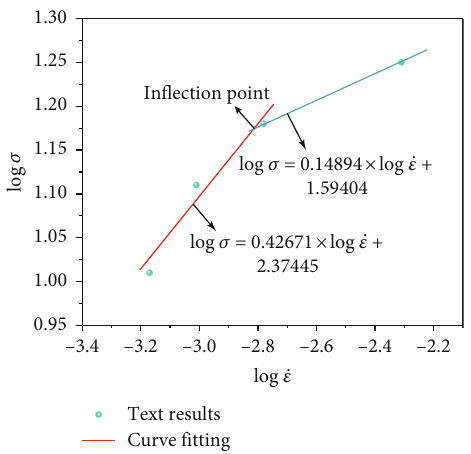
Figure 12: Double logarithmic creep rate in fl ection point